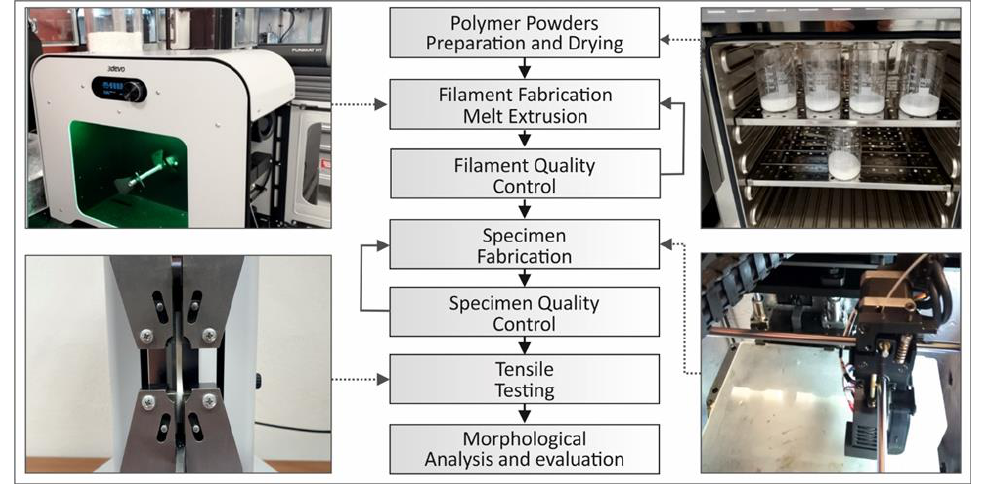
Figure 1. An overview diagram demonstrating the whole process followed to manufacture and test the five di ff erent polymeric